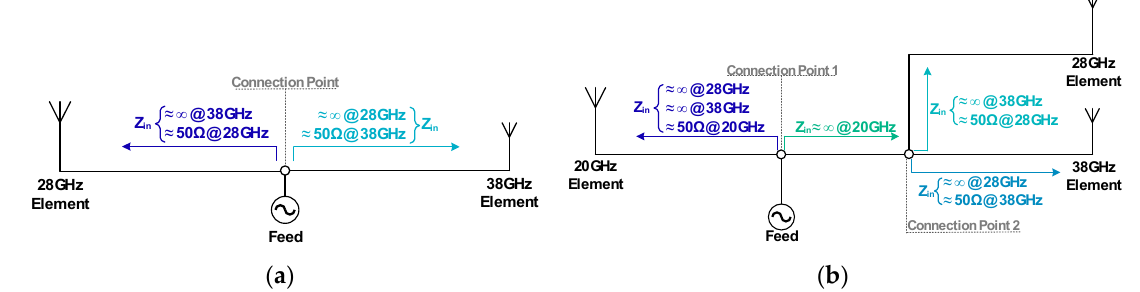
Figure 3. Schemes Proposed for the ( a ) Dual-Band and ( b ) Tri-Band antenna.